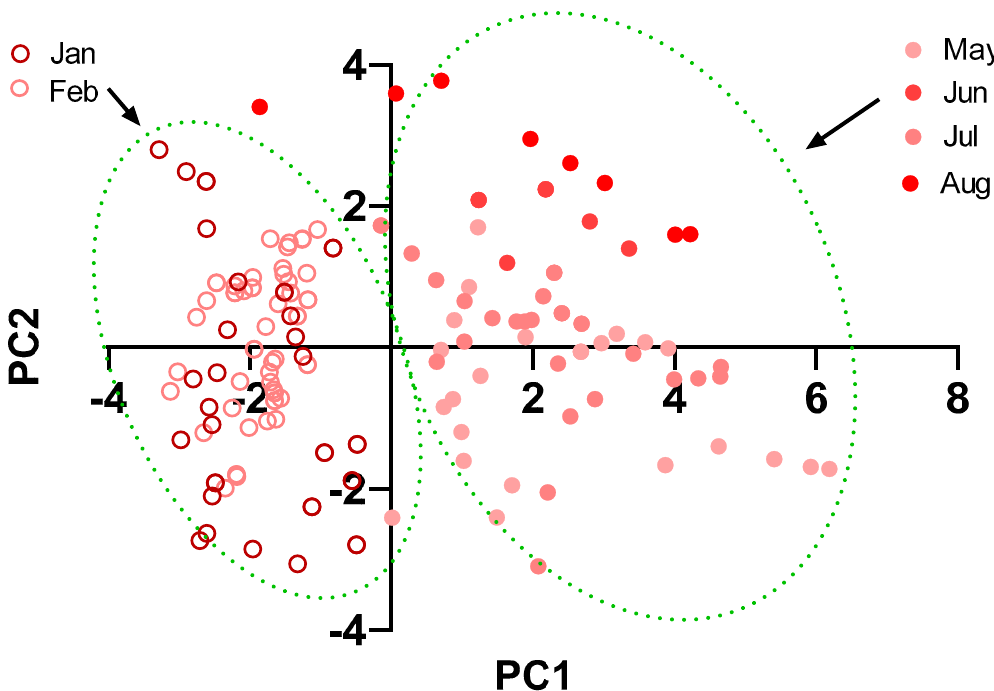
Figure 4. Individual values of PC1 versus PC2. The filled circles represent the values from the winter months, while the empty circles represent the values from the summer months.